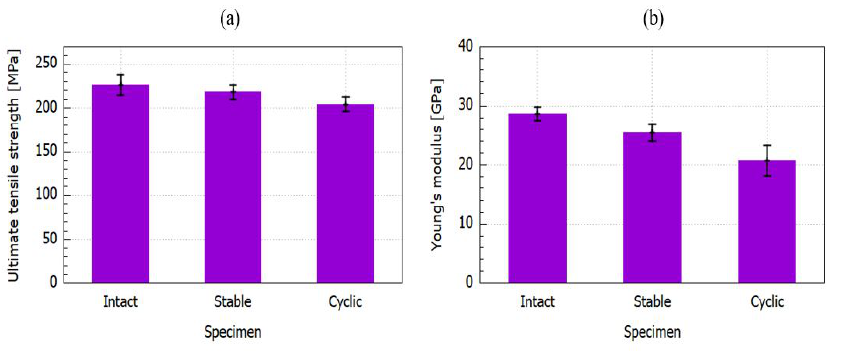
Figure 6. Experimental results of the tensile properties of 3D-printed samples. ( a ) Tensile strength; ( b ) Young’s modulus.